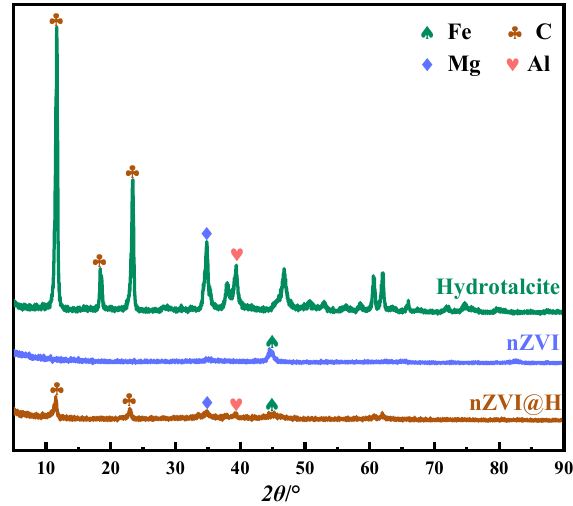
Figure 3. XRD images of hydrotalcite, nZVI and nZVI@H.